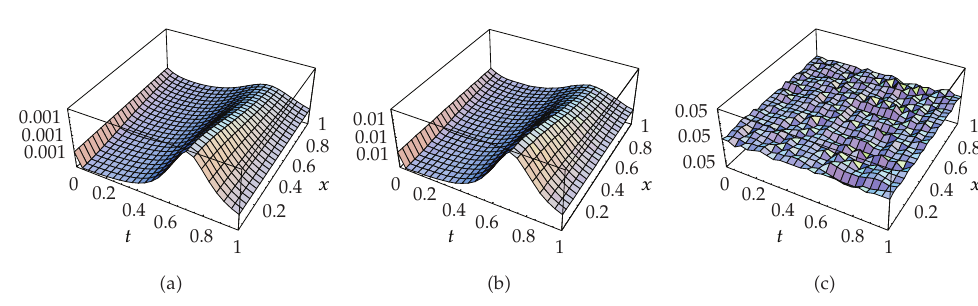
Figure 4: The figure of relative error | (cid:5) u − u 1 (cid:6) /u | with noise σ (cid:4) 0 . 1%, 1%, 5%, respectively, for Example